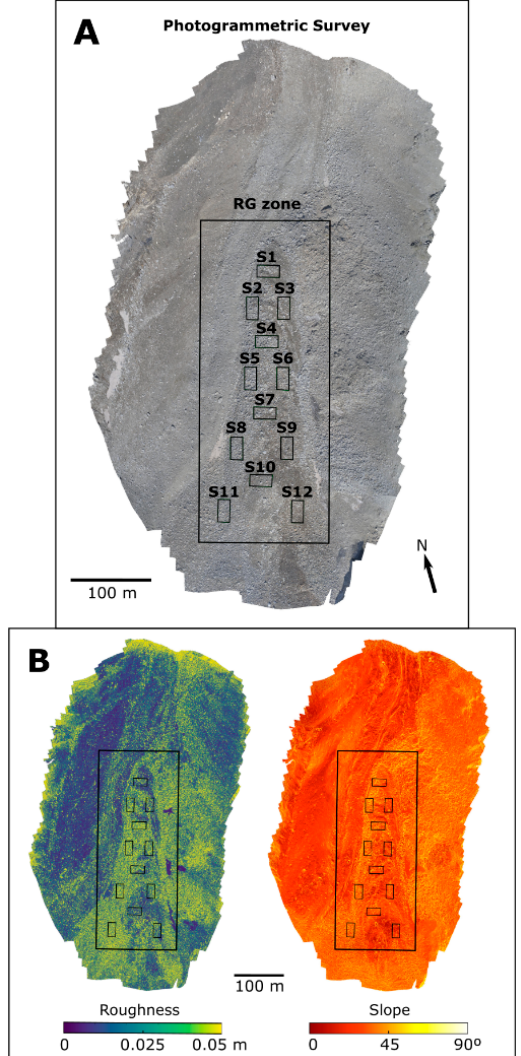
Figure 3. Levels of detail and geometric characteristics of the terrain in the photo reconstruction with JPEG images. ( A ) Surface extensions analysed. Photogrammetric survey, rock glacier zone (RG zone), and sectors (S). ( B ) Survey roughness (sphere 0.3 m radius) and slope (from point cloud normals) values.